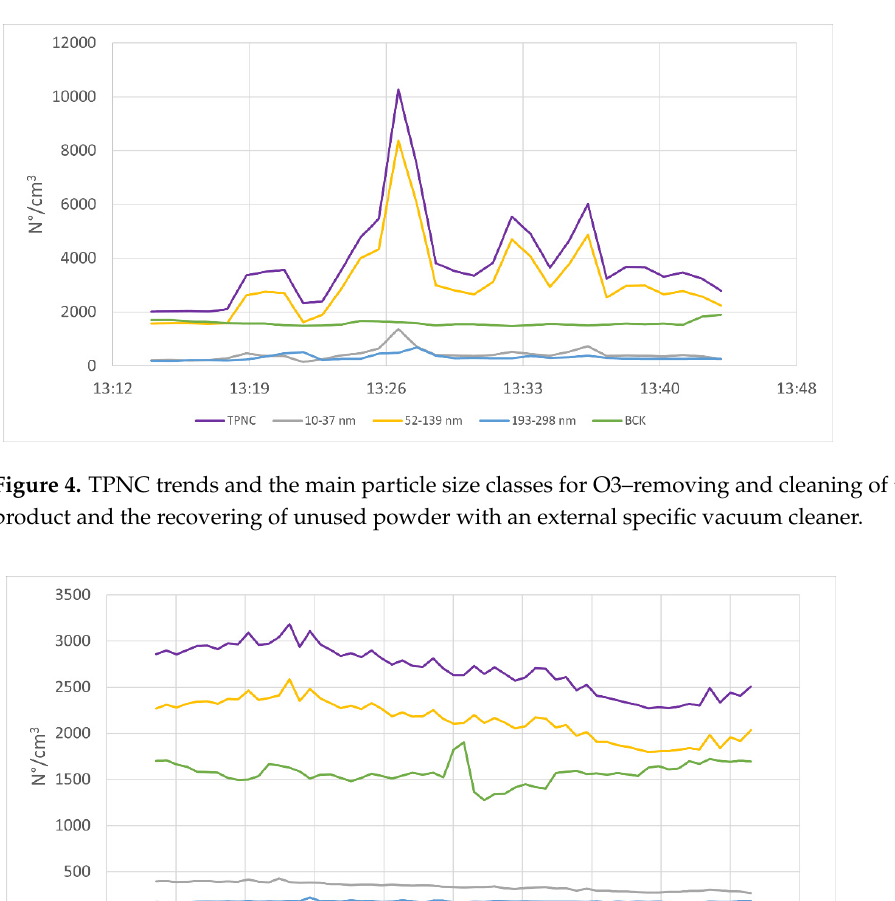
Figure 3. TPNC trends and the main particle size classes for O2–loading of the metal powder on the EOS 290 M with a closed system.